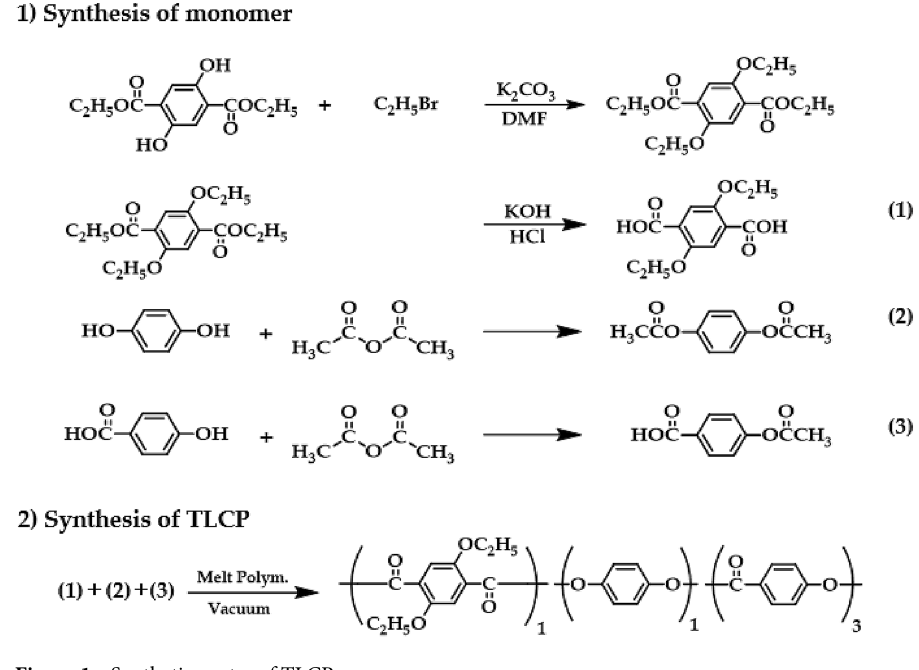
Figure 1. Synthetic routes of TLCPs.